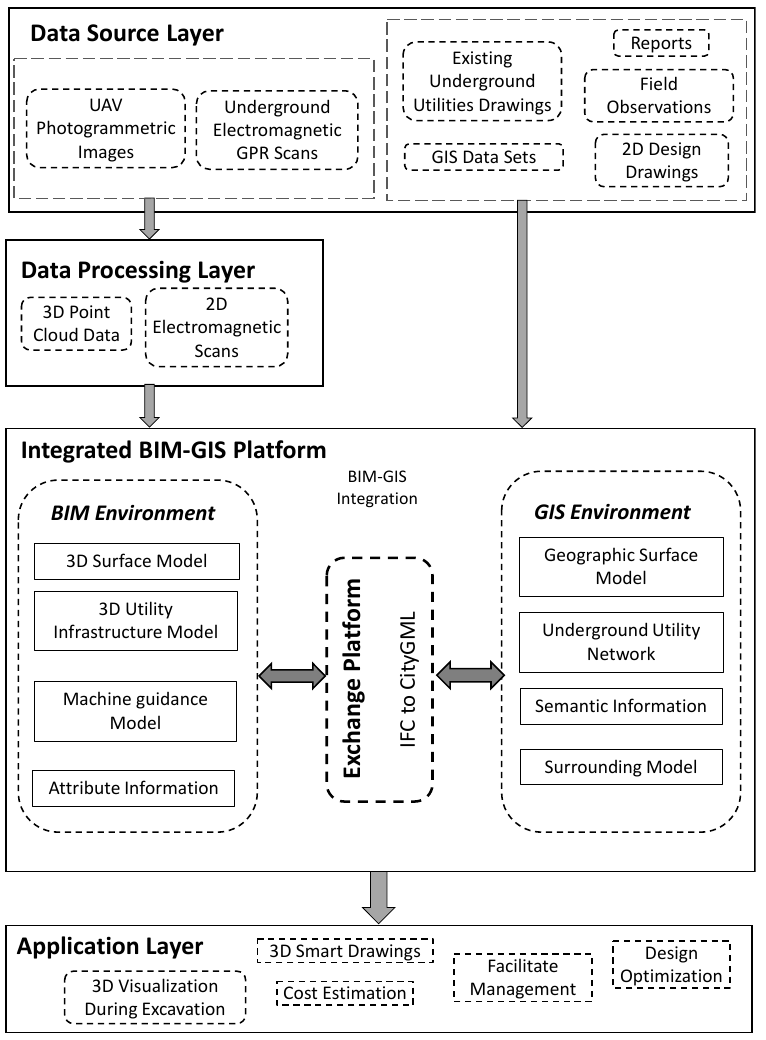
Figure 1. Concept overview.